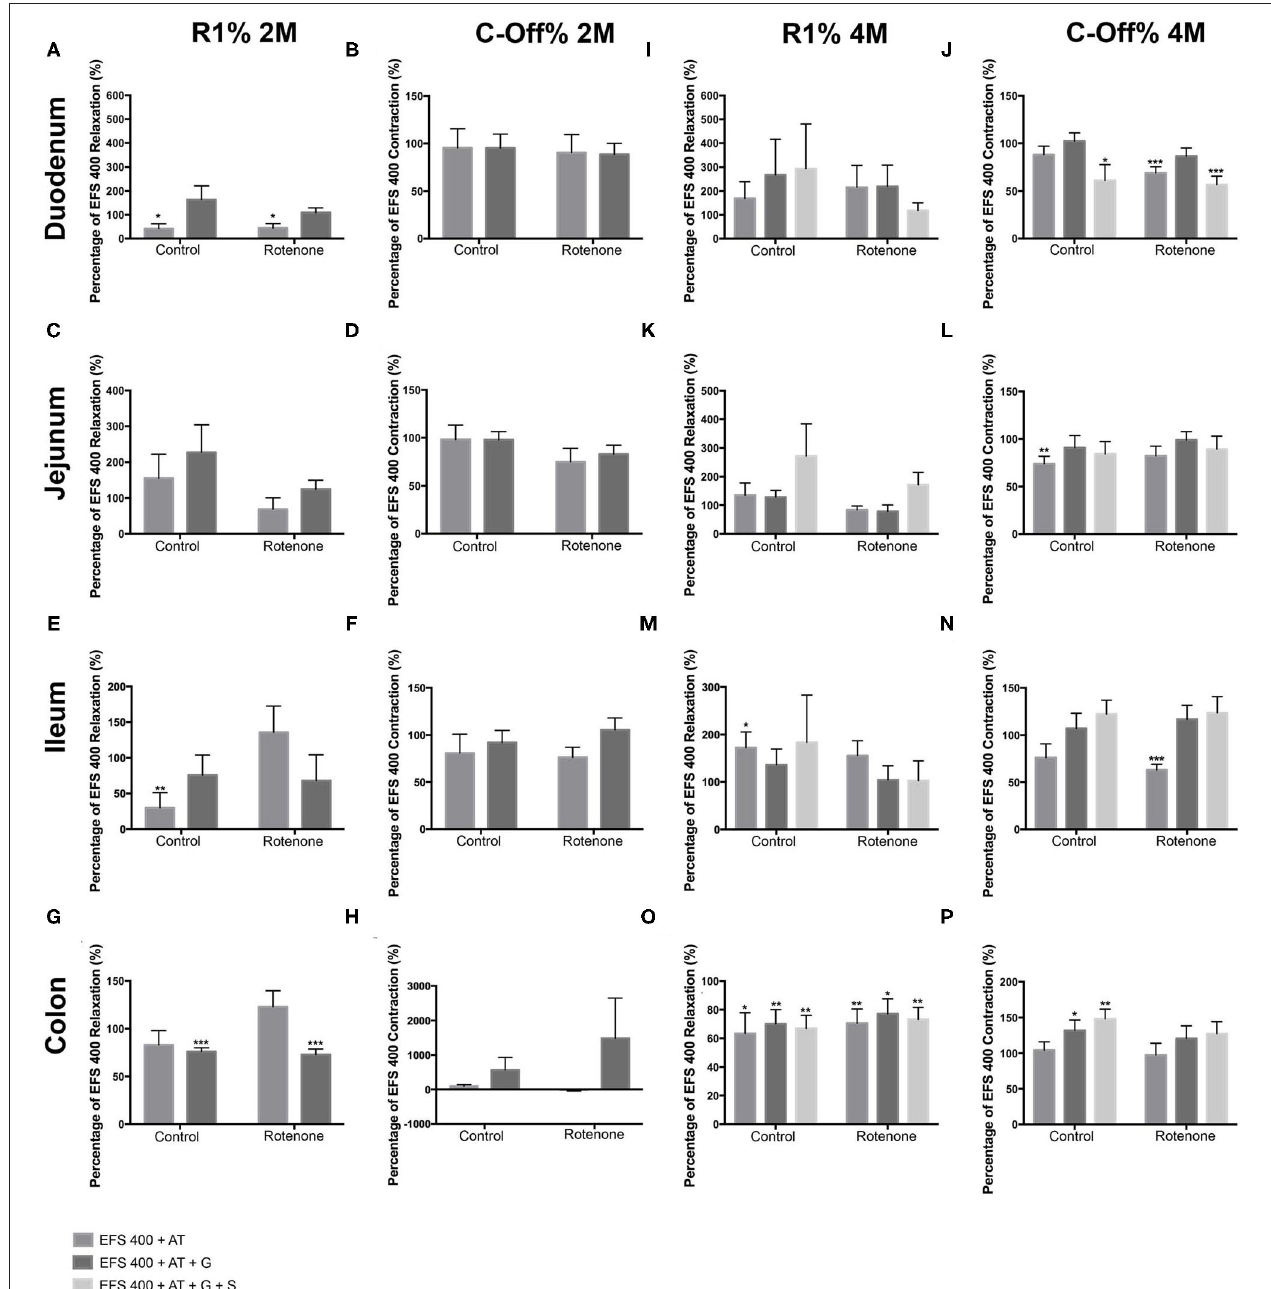
FIGURE 7 | Effect of a 400 µ s electric field stimulation (EFS 400) on the different intestinal regions after 2 and 4 months of exposure. In all regions, AT induced a deeper relaxation and a lower contraction when compared to the reaction observed without atropine (AT) or guanethidine (G) when EFS 200 and EFS 400 were applied. Data in figures is shown as a percentage of the EFS 200 or EFS 400 relaxation/contraction obtained without substances and the p -values refer to this percentage, if an additional significant difference between control and exposed samples is shown, the p -value will be written separately. (A–H) Graphics showing the R1 and the C-Off induced by EFS 200 on the duodenum (A,B) , jejunum (C,D) , ileum (E,F) , and colon (G,H) in Krebs solution alone, in the presence of atropine or in the presence of atropine and guanethidine after 2 months of rotenone exposure. (I–P) Graphics showing the R1 and the C-Off induced by EFS 200 on the duodenum (I,J) , jejunum (K,L) , ileum (M,N) , and colon (O,P) in Krebs solution alone, in the presence of atropine or in the presence of atropine and guanethidine after 4 months of rotenone exposure. Data was analyzed using a 2-way ANOVA Values of the effect of exposure are shown under the corresponding graph. *, **, *** correspond to P < 0.05, P < 0.01, and P < 0.001, respectively. Error bars represent SEM in all graphics. Data was analyzed using a Student’s t -test, *, **, *** correspond to P < 0.05, P < 0.01, and P < 0.001, respectively. Error bars represent SEM in all